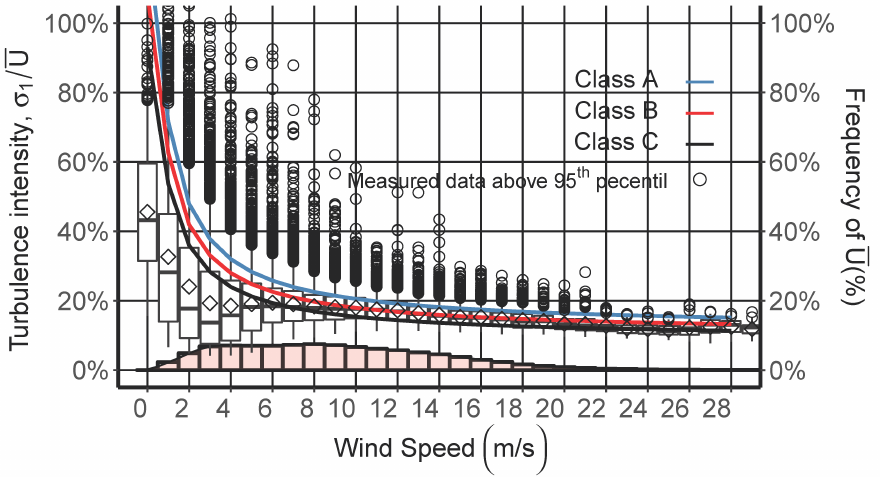
Figure 15. Box plot with NTM model of IEC61400-1 using different classes for measured LIDAR data at 75 meters high. The diamond shape located inside the box shows the average turbulence intensity value, and the histogram represents the wind speed frequency